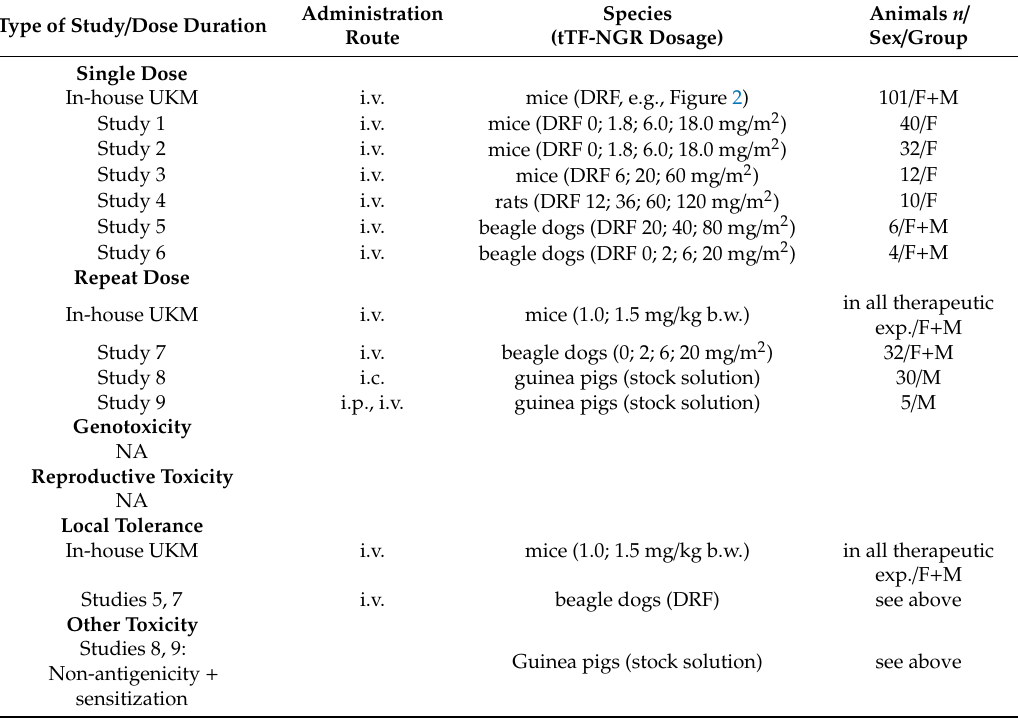
Table 1. List of toxicology studies performed according to ICH S9 (and S6) guidelines during the development of tTF-NGR.